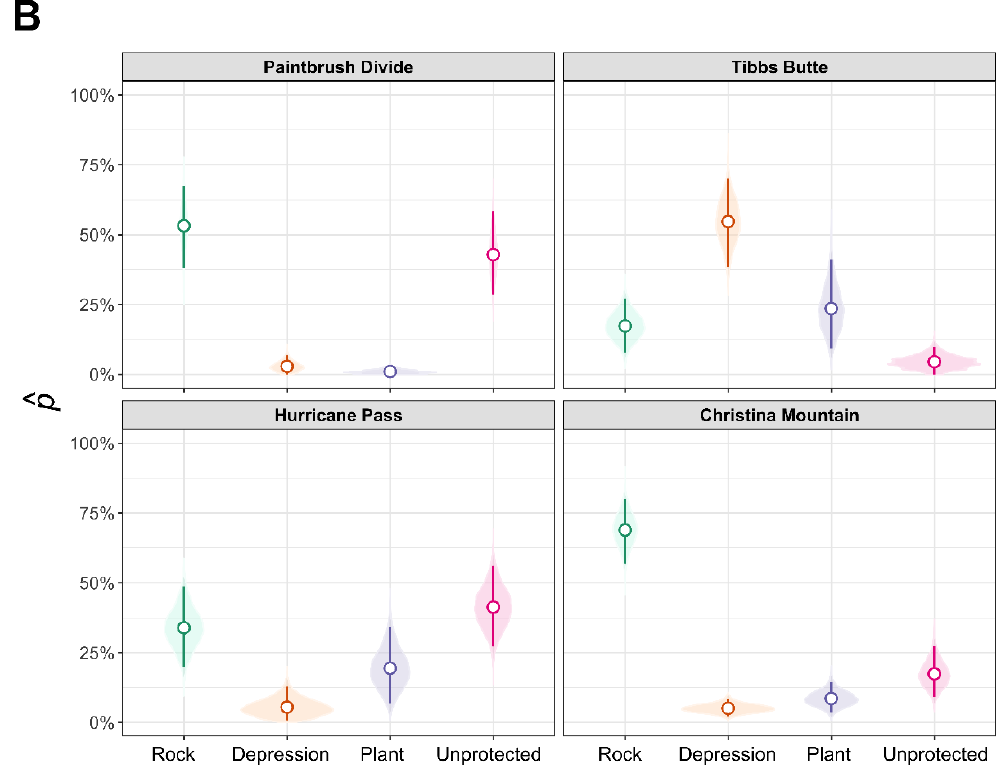
Figure 5. Parameter estimates for nurse object facilitation. ( A ) Pairwise mean differences in relative abundance between nurse objects. ( B ) Nurse object relative abundances. Shaded curves delineate sampling distributions, circles indicate parameter estimates, and vertical lines delineate 99.2% CIs ( A ) or 95% CIs ( B ). Closed circles in ( A ) denote significant differences.